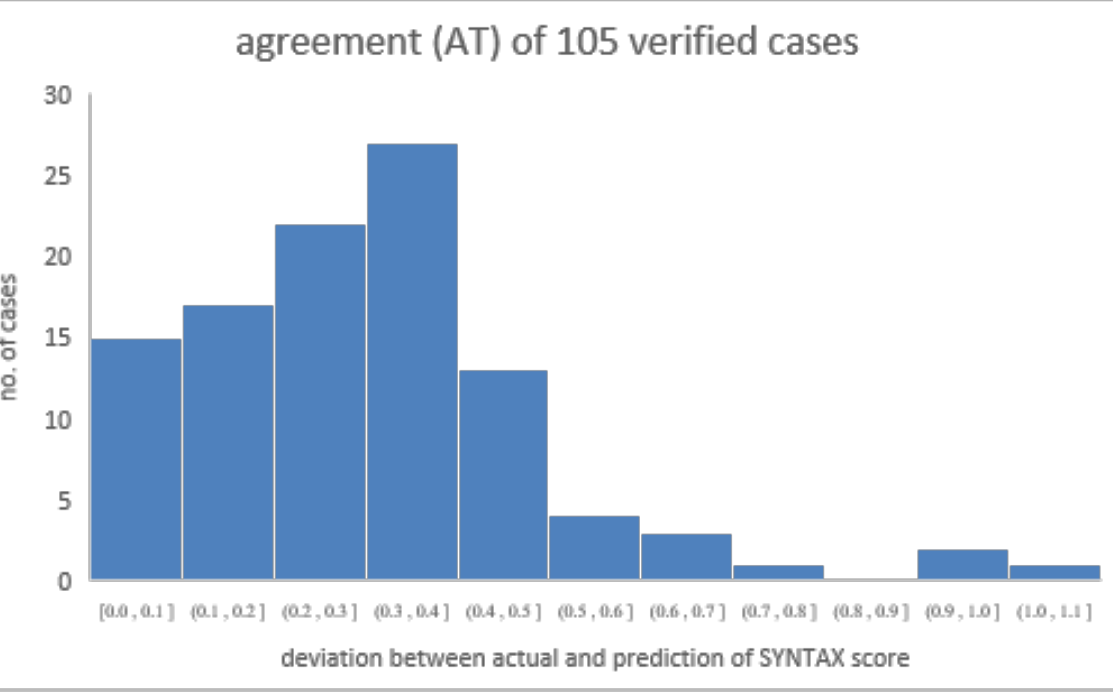
Figure 6. The distribution of 105 individual ATs in this study. As demonstrated, most ATs lie below 0.4, showing the convincing capability of the program to predict the SYNTAX score in reality. Table 4. Detailed information of the verified group of 105 patients with similar cardiovascular artery diseases was randomly adopted from the same patient group as the original one.